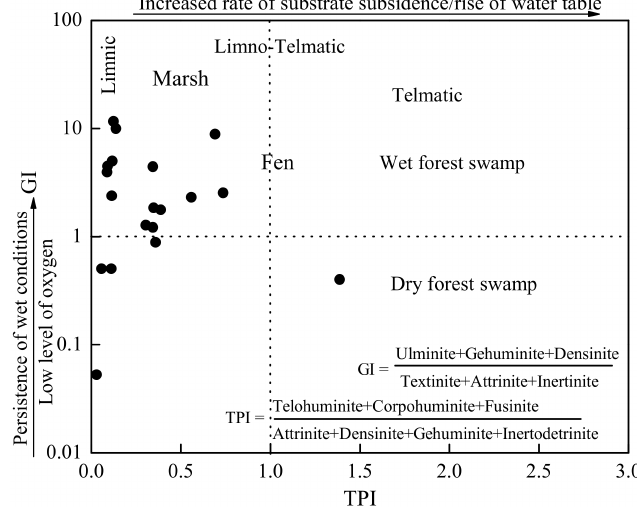
Figure 7. Plots of TPI and GI (after [9]). Reproduced with permission from Kalaitzidis et al.; published by 2004.